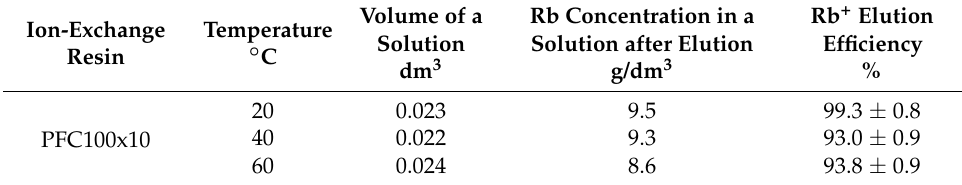
Table 6. Effect of temperature on the rubidium ion elution efficiency.